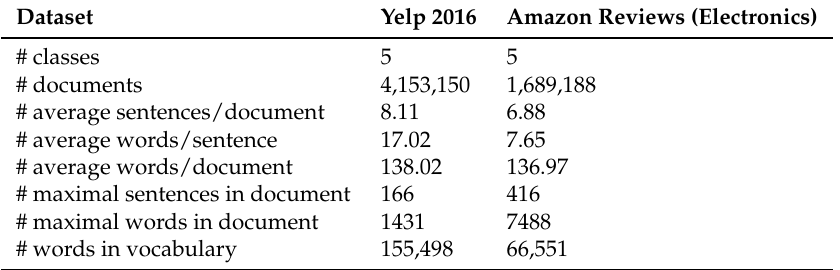
Table 2. Statistics of datasets (The vocabulary in datasets has gone through data cleaning, excluding single characters and punctuations as well as retaining only the lemmatized